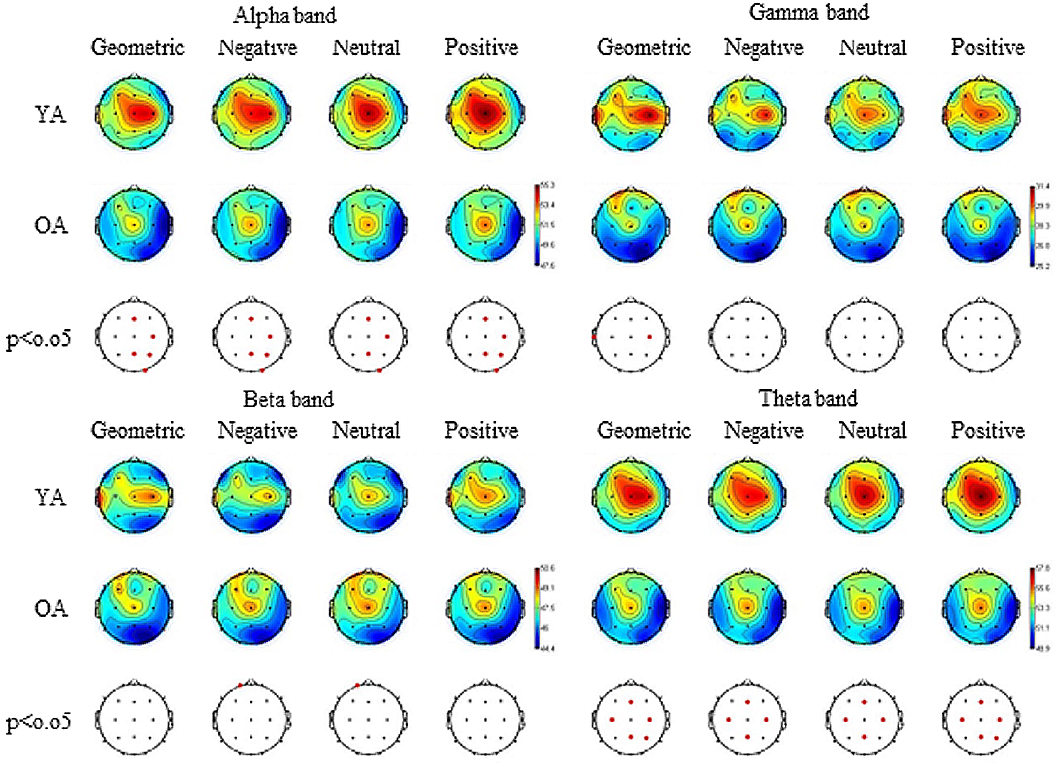
Figure 2. Relative topographic power spectrum distribution for specific bands with each stimulus category and age group. Stimulus categories are: geometric pictures, negative, neutral and positive faces. Age groups are: young adults (YA) and older adults (OA). Alpha activity: 8 to 13 Hz, Beta activity: 13 to 30 Hz, Gamma activity: 30 to 70 Hz, Theta activity: 4 to 8 Hz. Red dots indicate significant statistical differences (p , 0.05; parametrical tests) related to age groups in electrode location.